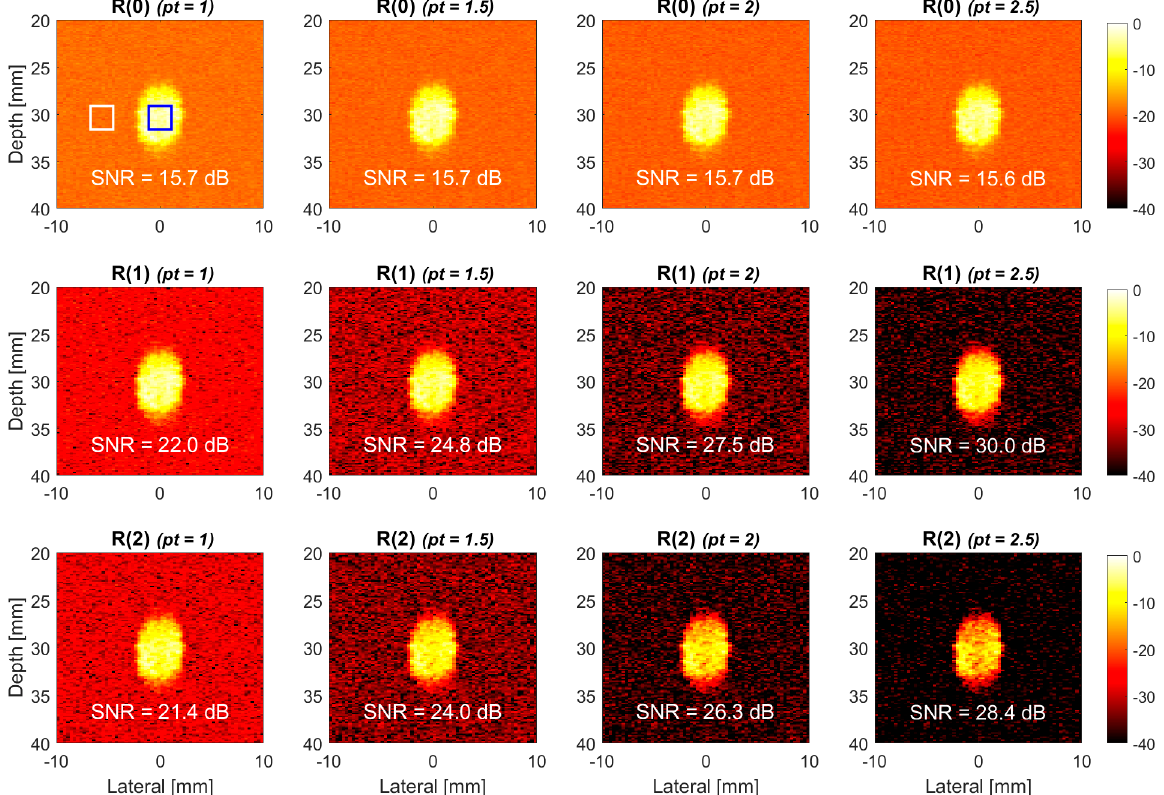
Figure 3. Simulated TMAS power Doppler images of cross-view flow phantom for R(0), R(1) and R(2) images with the pt values of 1.0, 1.5, 2.0 and 2.5, respectively, from left to right. The flow velocity is 150 mm/s, and the inclined angle is 30°.